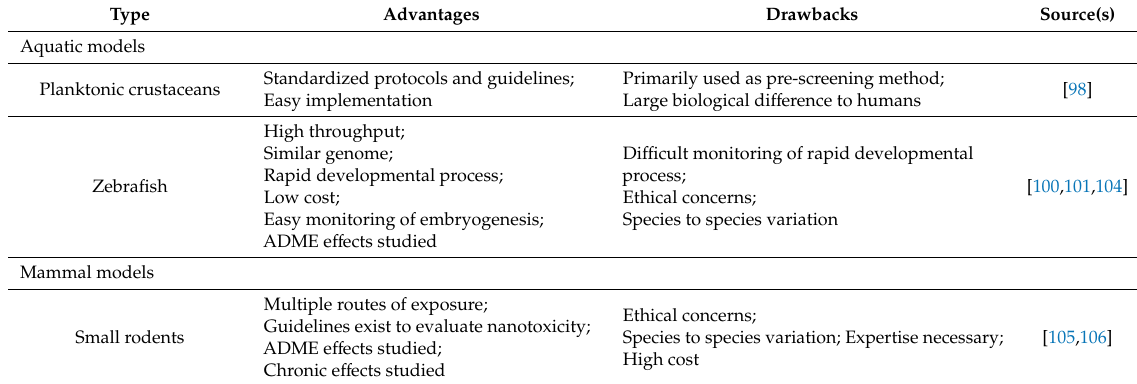
Table 2. The advantages and drawbacks of the various in vivo methods. ADME: Absorption, distribution, metabolism, and